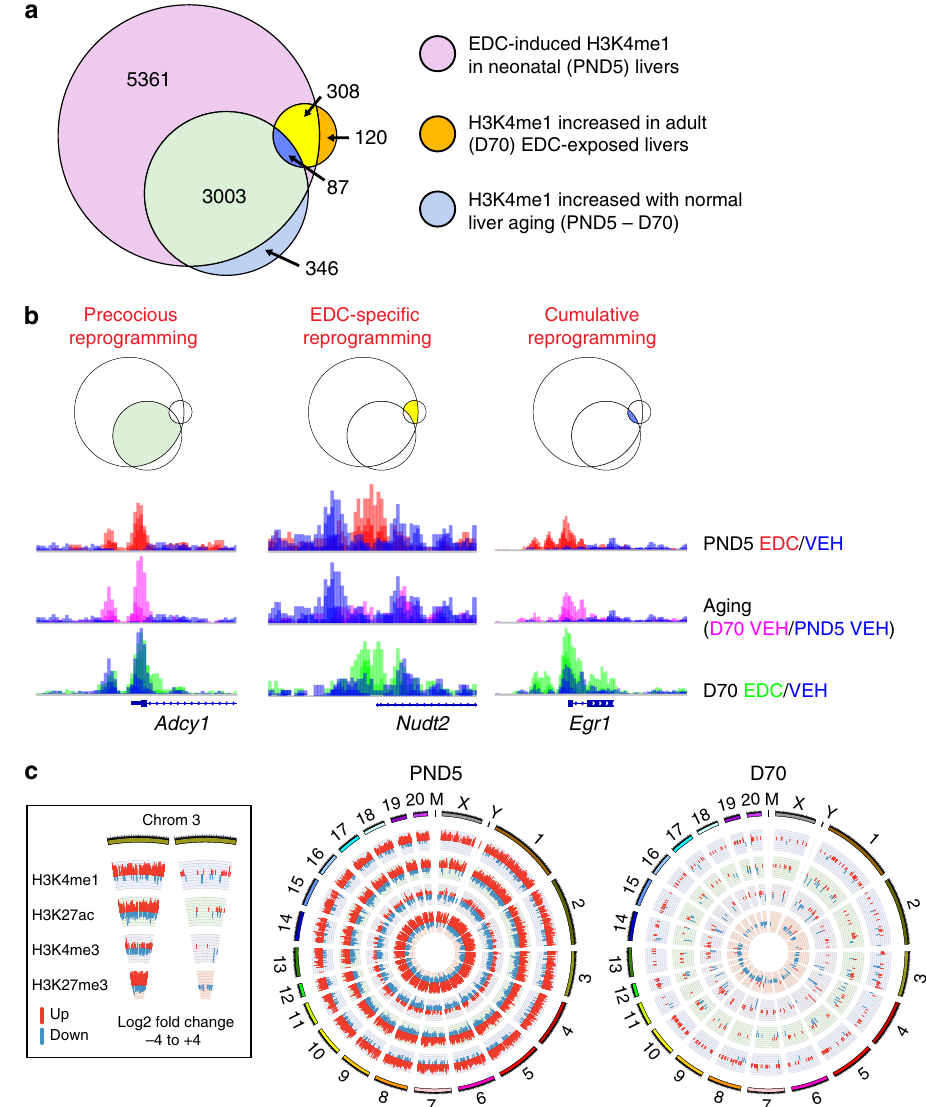
Fig. 2 EDC exposure hijacks age-related epigenomic plasticity to accelerate epigenomic aging. a Venn diagrams for increased H3K4me1 focused on histone modi fi cations associated with target genes, de fi ned as having differential peak calls within ±3 kb of the transcriptional start site (TSS), using the GENCODE gene model and the BEDTOOLS software ( N = 3 biologically independent animals per timepoint/treatment). b Integrated genome viewer (IGV) showing representative examples of each type of reprogramming for increased H3K4me1 at target genes: Precocious Reprogramming illustrated by Adcy1 , EDC-speci fi c Reprogramming illustrated by Nudt2, and Cumulative Reprogramming illustrated by Egr1 . The data shown on the y -axis are the ChIP-seq read counts normalized to 1 million mapped reads. c Circos plots of differential peaks identi fi ed by chromatin immunoprecipitation sequencing (ChIP-seq) at target genes for active and repressive epigenetic histone modi fi cations. Epigenomic data were analyzed using the rn6 rat genome build and the latest GENCODE gene model. For each of the four histone modi fi cations, differential peaks that distinguished EDC ( N = 3 per timepoint) from vehicle ( N = 3 biologically independent animals per timepoint) exposed neonates (PND5) and adults (D70) were identi fi ed using DiffReps, with signi fi cance achieved at q < 0.01 and fold change exceeding 2×. Peaks with enrichment of the histone mark are indicated in red, while peaks with loss of the histone mark are indicated in